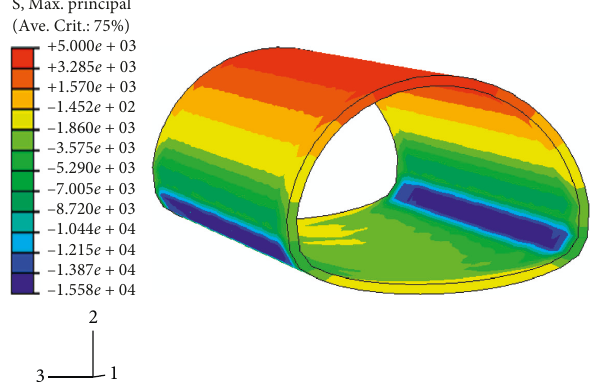
Figure 15: Main stress cloud diagram of secondary lining of Jia Hua Tunnel Left Line (unit: